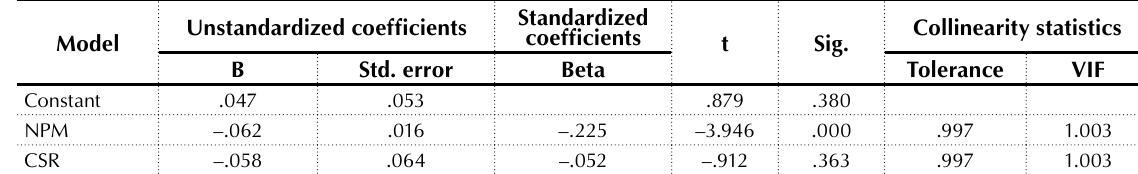
Table 4. Multicollinearity test